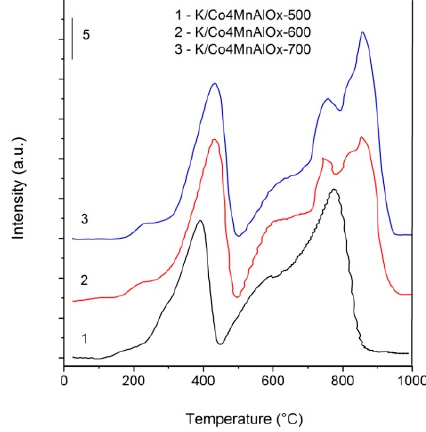
Figure 2. TPR-H 2 patterns of the K/Co 4 MnAlO x mixed oxide calcined at different temperatures.